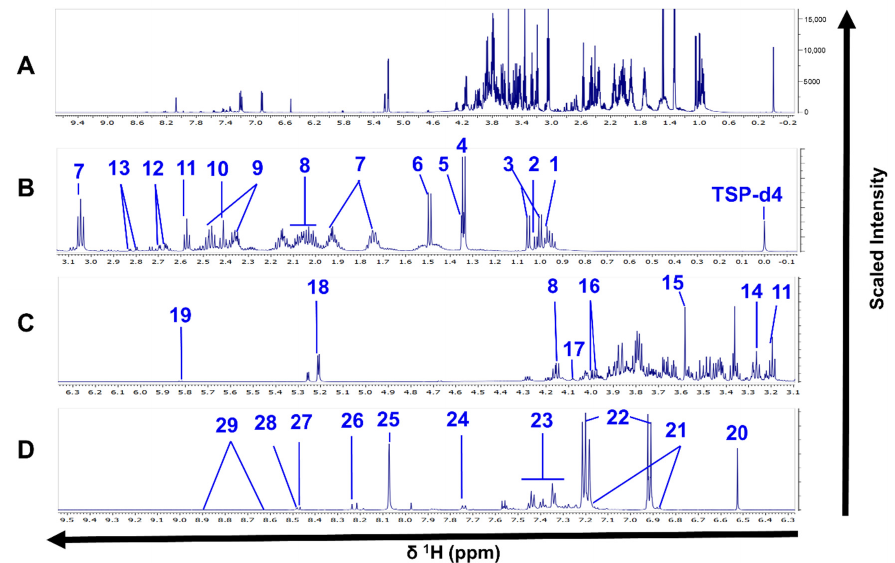
Figure 3. 1 H-NMR spectra of L. tropica extracellular extract. ( A ) Full 1 H-NMR spectrum from δ 0.0 to δ 9.5 (TSP- d 4 as an internal standard with chemical shift at δ 0.0). ( B ) Enlarged spectrum from δ 0.0 to δ 3.1. ( C ) Enlarged spectrum from δ 3.1 to δ 6.3. ( D ) Enlarged spectrum from δ 6.3 to δ 9.5. Peaks of 29 compounds: 1, leucine; 2, isoleucine; 2, valine; 4, lactate; 5, threonine; 6, alanine; 7, lysine; 8, proline; 9, glutamine; 10, succinate, 11, ß-alanine; 12, malate; 13, aspartate; 14, arginine; 15, glycine; 16, L -serine; 17, myoinositol; 18, trehalose; 19, uracil; 20, fumarate; 21, N -acetyl tyrosine; 22, tyrosine; 23, phe- nylalanine; 24, tryptophan, 25, methylhistidine; 26, hypoxanthine; 27, formate; 28, imidazole, 29, nicotinate. Only one spec- trum is represented for simplification. The spectrum corresponds to the HR strain.